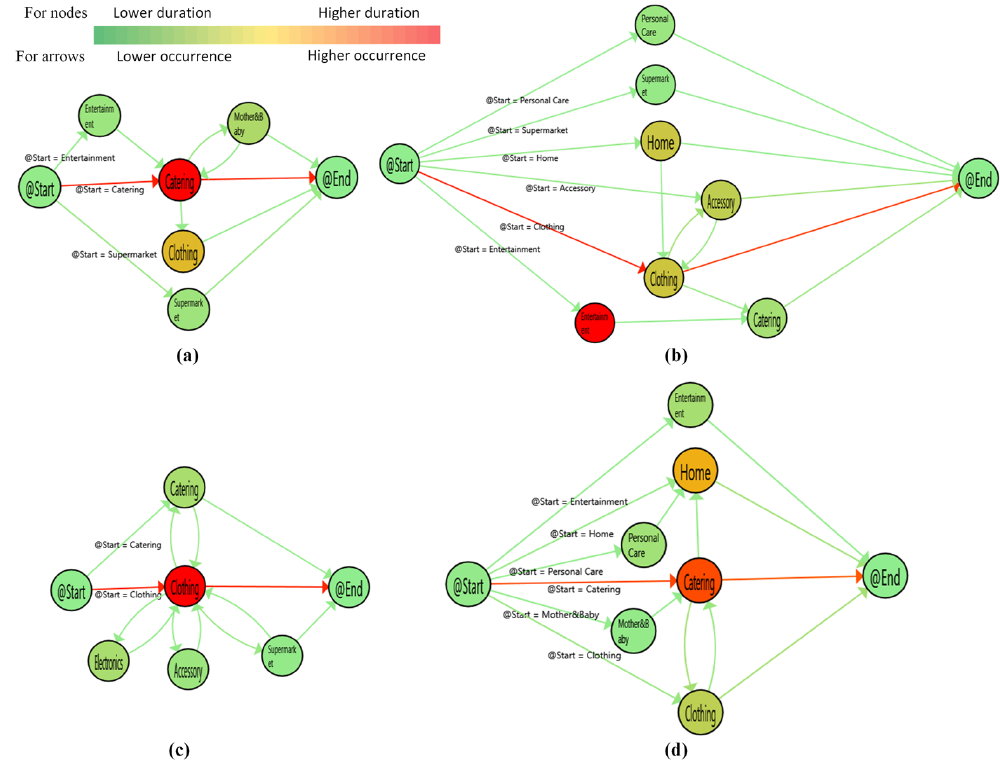
Figure 6. Customers’ paths in January. ( a ): Male paths-1st cluster ( b ): Female paths-1st cluster ( c ): Male paths-2nd cluster ( d ): Female paths-2nd